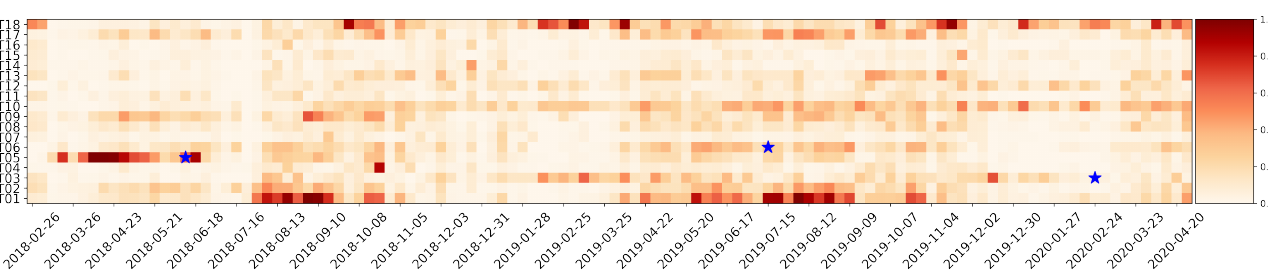
Figure 2. Scatter plot showing the isolation forest indicator vs. the neural network indicator independently for each WT. The linear regression model fit, that minimizes the squared error of the data, is plot in red. The shaded area represents the 68% confidence interval of the model. Pearson correlation coefficient and p -value for testing non-correlation are reported as r and p , respectively.